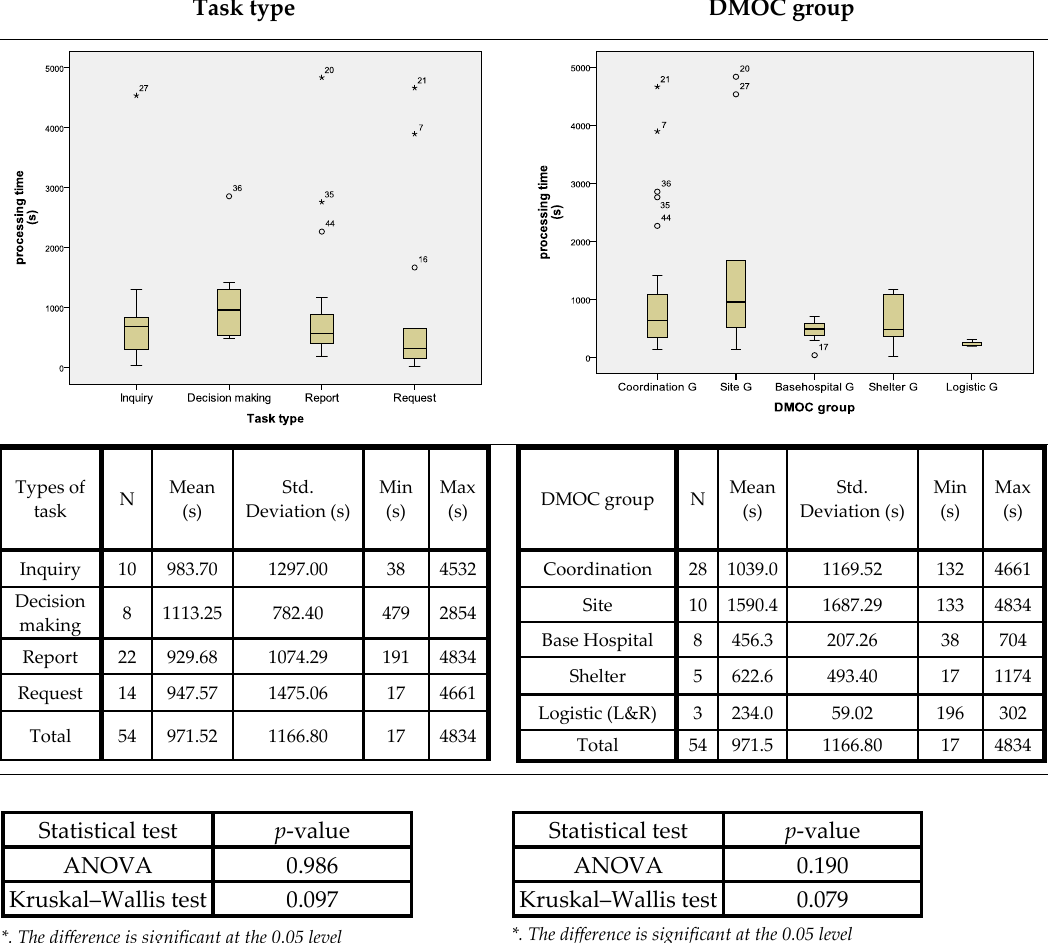
Figure 4. Task processing time across task types and DMOC groups in November.